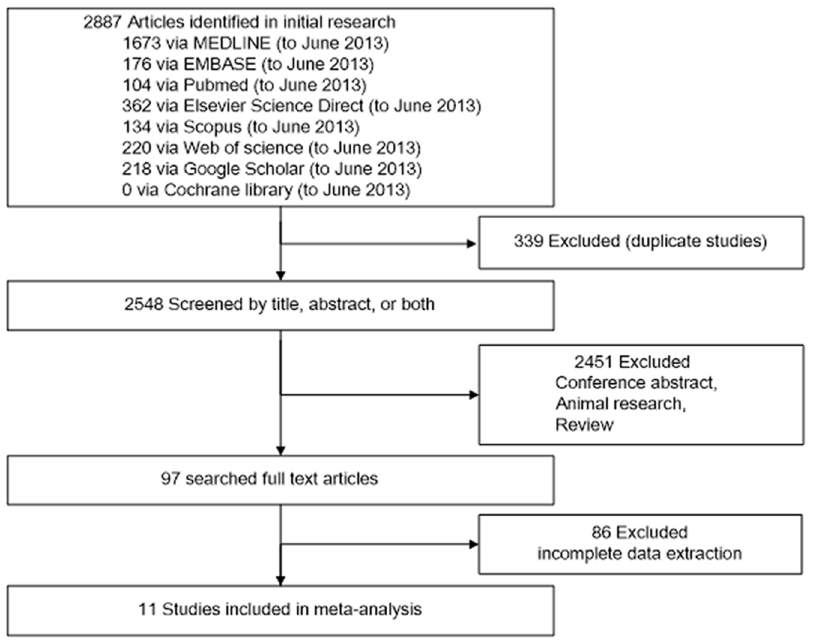
Figure 1. Flow diagram for the review process and outcomes of inclusion and exclusion.